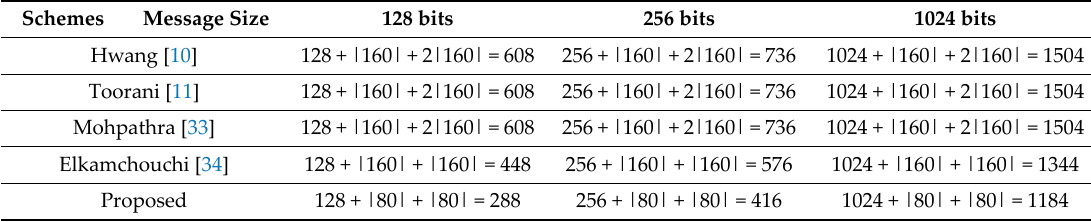
Table 5. Communication cost comparisons in terms of size of cipher text.